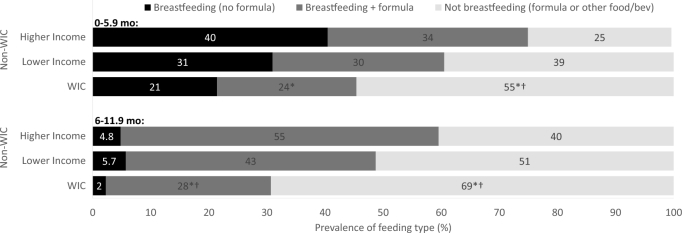
Percentage of mothers exclusively or partially breastfeeding infants 0–5.9 and 6–11.9 mo by WIC participation status. *WIC significantly different than higher-income (likely not WIC-eligible) nonparticipants, P < 0.05; †WIC significantly different than lower-income (likely WIC-eligible) nonparticipants, P < 0.05; based on Rao-Scott modified chi-square test. WIC, Special Supplemental Nutrition Program for Women, Infants, and Children.